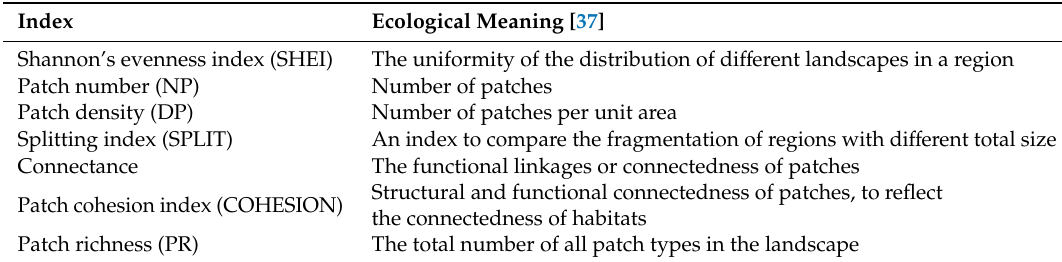
Table 2. Descriptions of landscape pattern metrics used in this study.